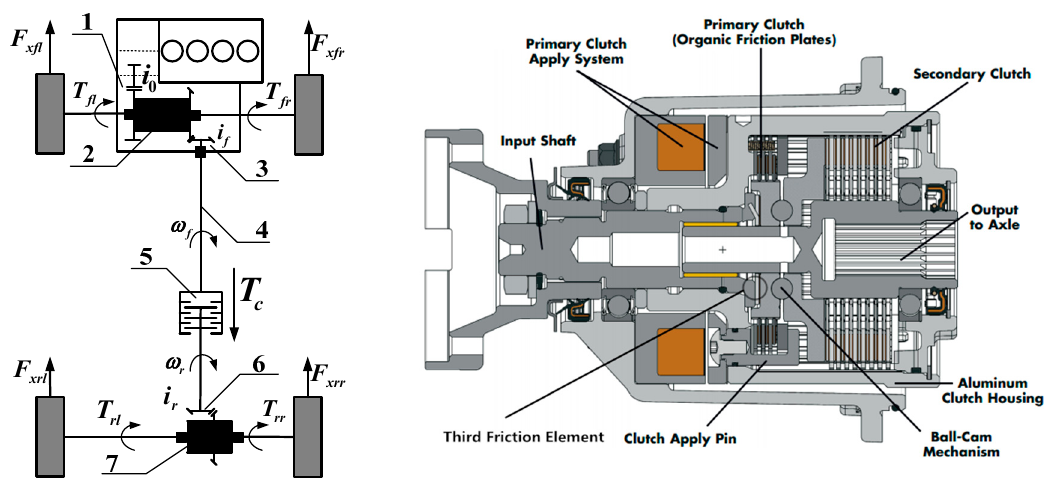
Figure 1. Whole vehicle layout and the EMTC; 1—final reducing drive, 2—assembly of front axle di ff erential, 3—power transfer unit, 4—driving shaft, 5—center coupling, 6—rear axle reducer, 7—assembly of rear axle di ff